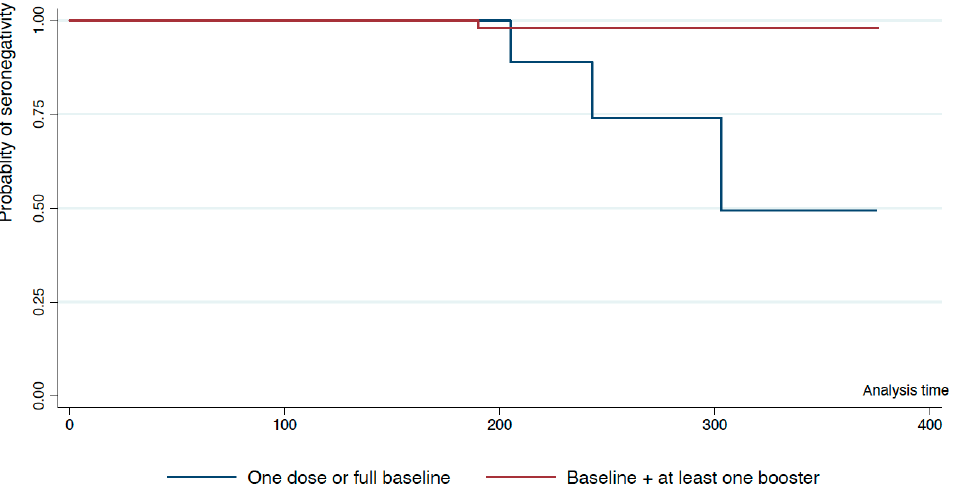
Figure 2. Kaplan–Meyer analysis shows probability of antibody loss over time, measured in days, depending on the dose of vaccine received.